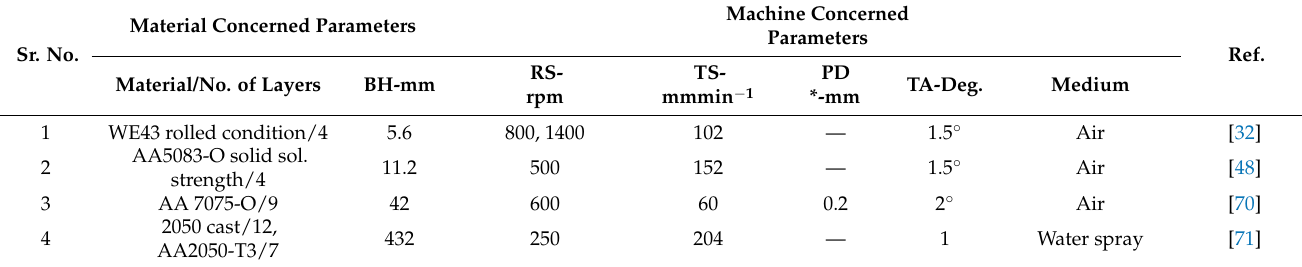
Table 2. Overview of material concerned, and machine concerned parameters applied by the vari- ous researchers.